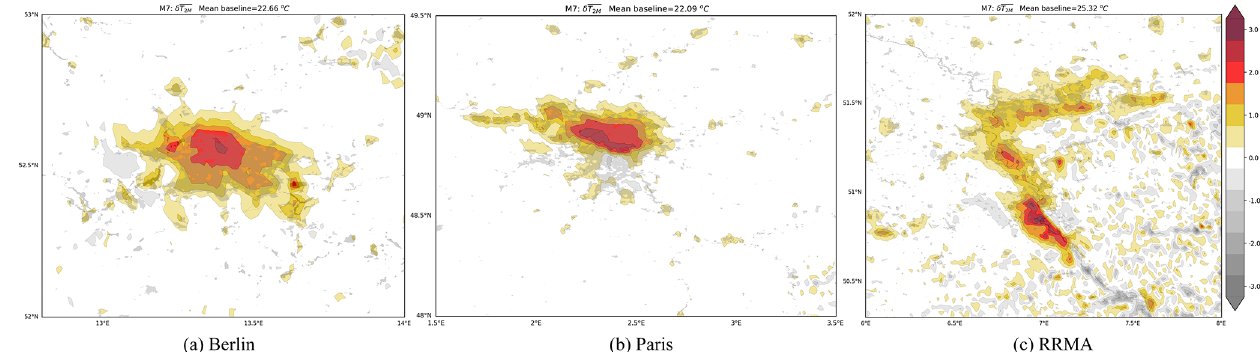
Figure 5. UHI as calculated with M7 on the original grid (no interpolation) for Berlin, Paris and the Rhine-Ruhr Metropolitan Area (a–c) .